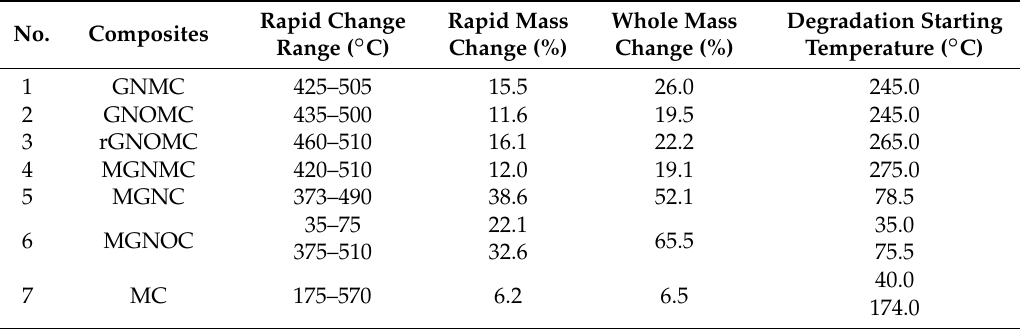
Figure 8. ( a ) TGA and ( b ) DTG curves of composites. Table 2. Comparison of mass changes of composites.